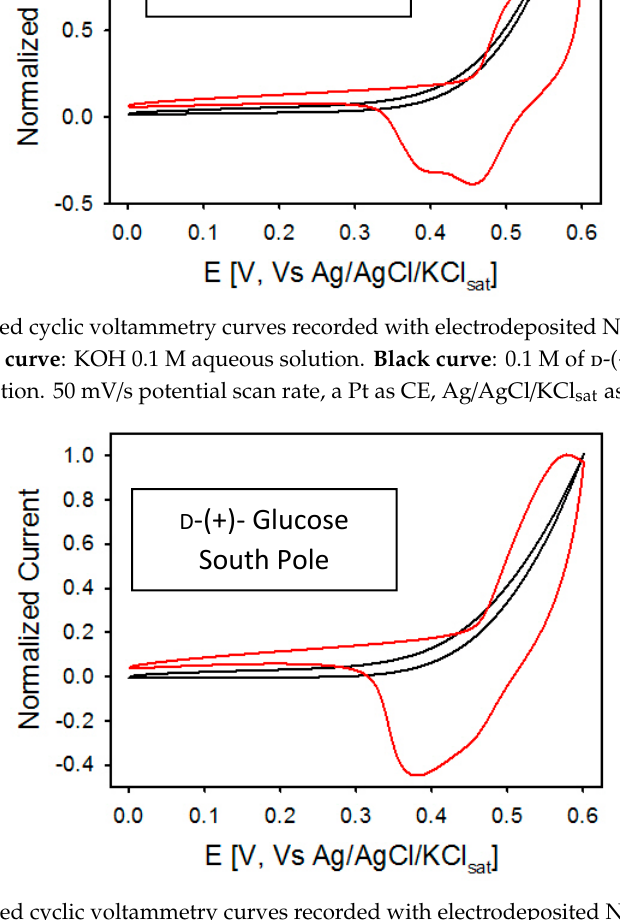
Figure 4. Normalized cyclic voltammetry curves recorded with electrodeposited Ni on the North pole of the magnet. Red curve : KOH 0.1 M aqueous solution. Black curve : 0.1 M of D -(+)-Glucose in KOH 0.1 M aqueous solution. 50 mV/s potential scan rate, a Pt as CE, Ag/AgCl/KCl sat as RE.